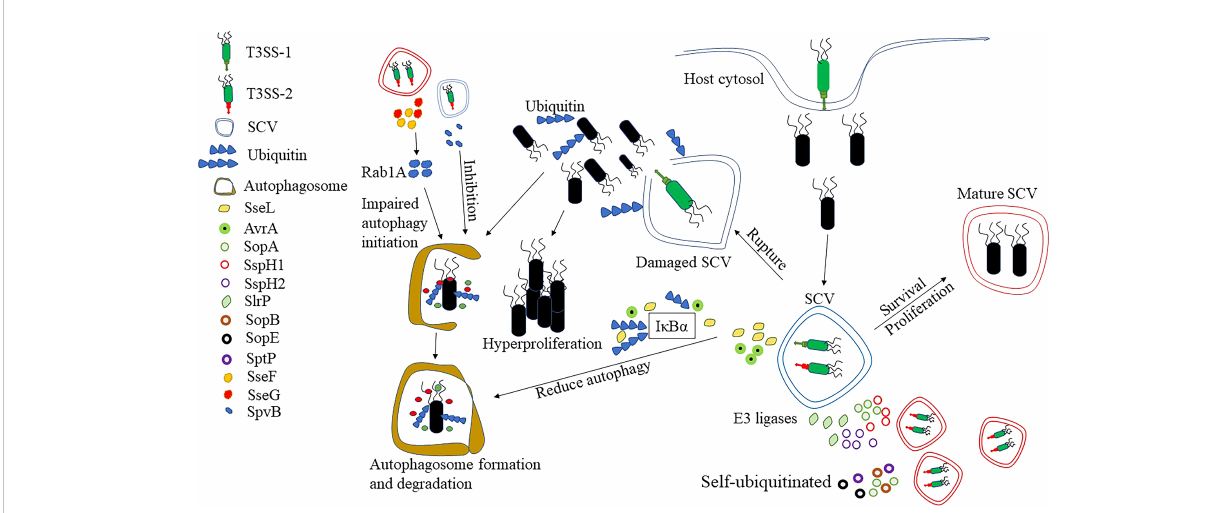
FIGURE 3 Response of Salmonella to ubiquitination and autophagy. After entering the cytosol, Salmonella can develop a unique ecological niche, SCVs. By the presence of SCVs, Salmonella can avoid recognition by ubiquitination, but studies have shown that the integrity of SCVs can be disrupted by T3SS-1. Some of the Salmonellae escape into the cytoplasm and hyper-proliferate, but there are also some bacteria recognized by ubiquitination. At the same time, ubiquitin also recognizes the damaged SCVs and the bacteria that remain inside the SCVs, and eventually clears the SCVs and bacteria by enzymatic reaction. However, Salmonella can effectively avoid the accumulation of ubiquitin aggregates and aggregate-like induced structures by secreting deubiquitinating enzymes, such as SseL and AvrA, which in turn prevent the recognition of ubiquitin-like modi fi cations by autophagy receptors. There are also effector proteins, such as SopA, SspH1, SspH2 and Slrp that can act as E3 ligases to ubiquitinate host proteins and thus inhibit in fl ammatory responses. Finally, effector proteins such as SopA, SopB, SopE or SptP can also self-ubiquitinate to in fl uence the antimicrobial response. The disruption of ubiquitination by SseL is also able to reduce the occurrence of autophagy. SseF and SseG, on the other hand, can interact with the small GTPase Rab1A in the host cell to inhibit autophagy initiation. Finally, SpvB depolymerizes actin, inhibiting host cell autophagy, which is also important for Salmonella intracellular